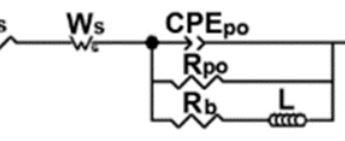
Figure 11. The equivalent electrical circuit used by [32] to simulate the electrochemical behavior of PEO coatings obtained in silicate or aluminate-based electrolytic solutions.